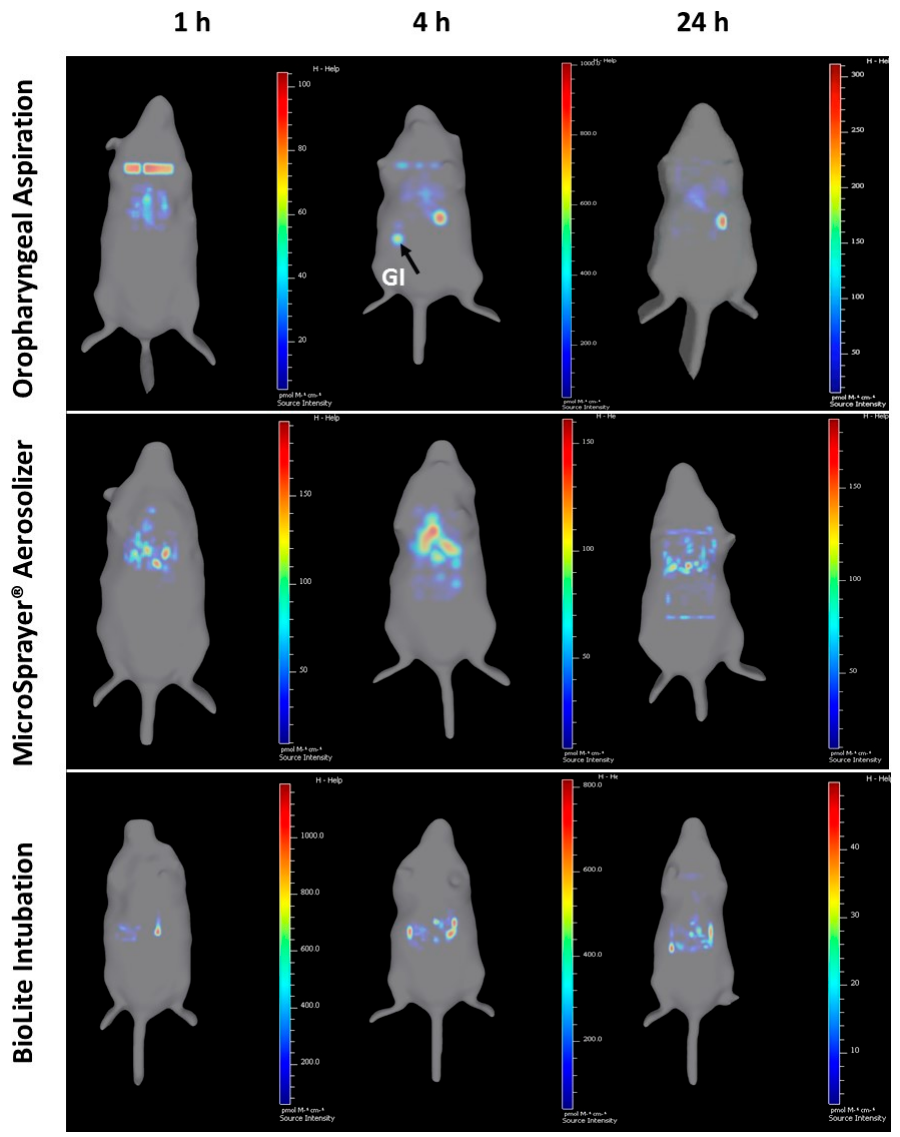
Figure 9. Three-dimensional (3D) longitudinal imaging of mouse at 1, 4, and 24 h using IVIS Spectrum after administration of near-infrared fluorescent Degradex ® poly(D,L-lactide-co-glycolide) (PLGA) microspheres using oropharyngeal aspiration, the MicroSprayer ® Aerosolizer, and the BioLite Intubation System (3D video available as Supplementary Video S1). Gastrointestinal (GI) deposition using the oropharyngeal aspiration technique is shown with an arrow.